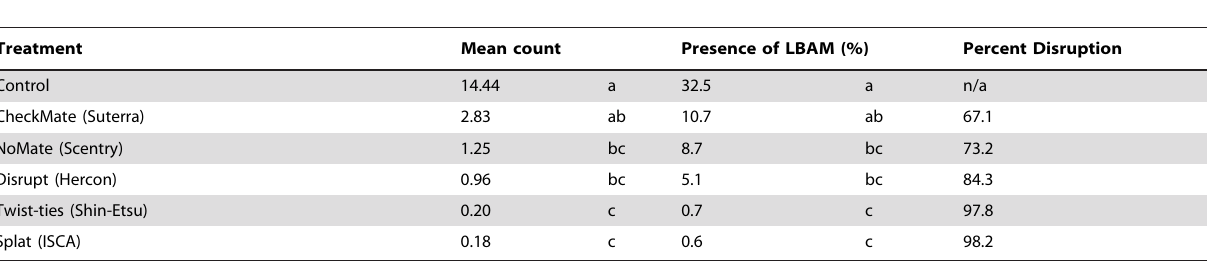
Table 1. Trap catch of light brown apple moth and percent trap disruption following application of pheromone formulations for mating disruption over 13 weeks following treatment, expressed as covariate-adjusted, back-transformed mean summed counts, percent presence, and percent disruption (for traps at 1.5 m above ground).